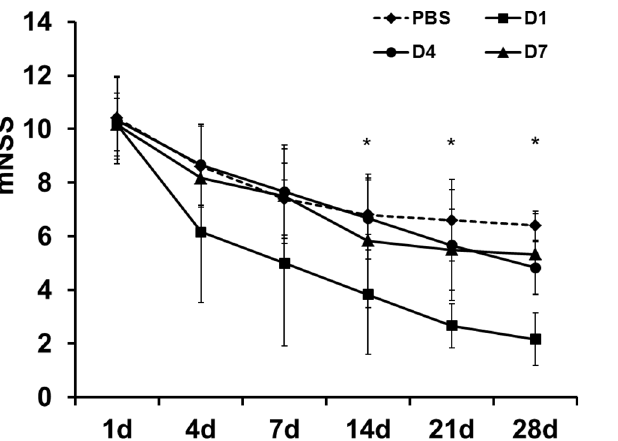
Fig 2. Modified Neurological Severity Score (mNSS) results according to the time after MCAo. The mNSS was lower in the D1 group compared to the control (PBS group), D4, or D7 groups at each time point 14 days after MCAo ( * P < 0.05) (n = 7 per group). MCAo indicates middle cerebral artery